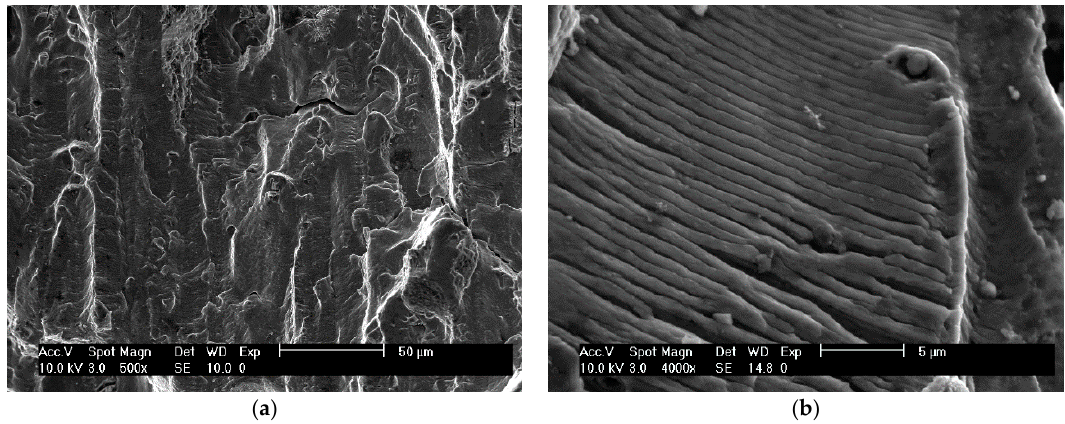
Figure 11. Exemplary fracture surface morphology from SEM observations.